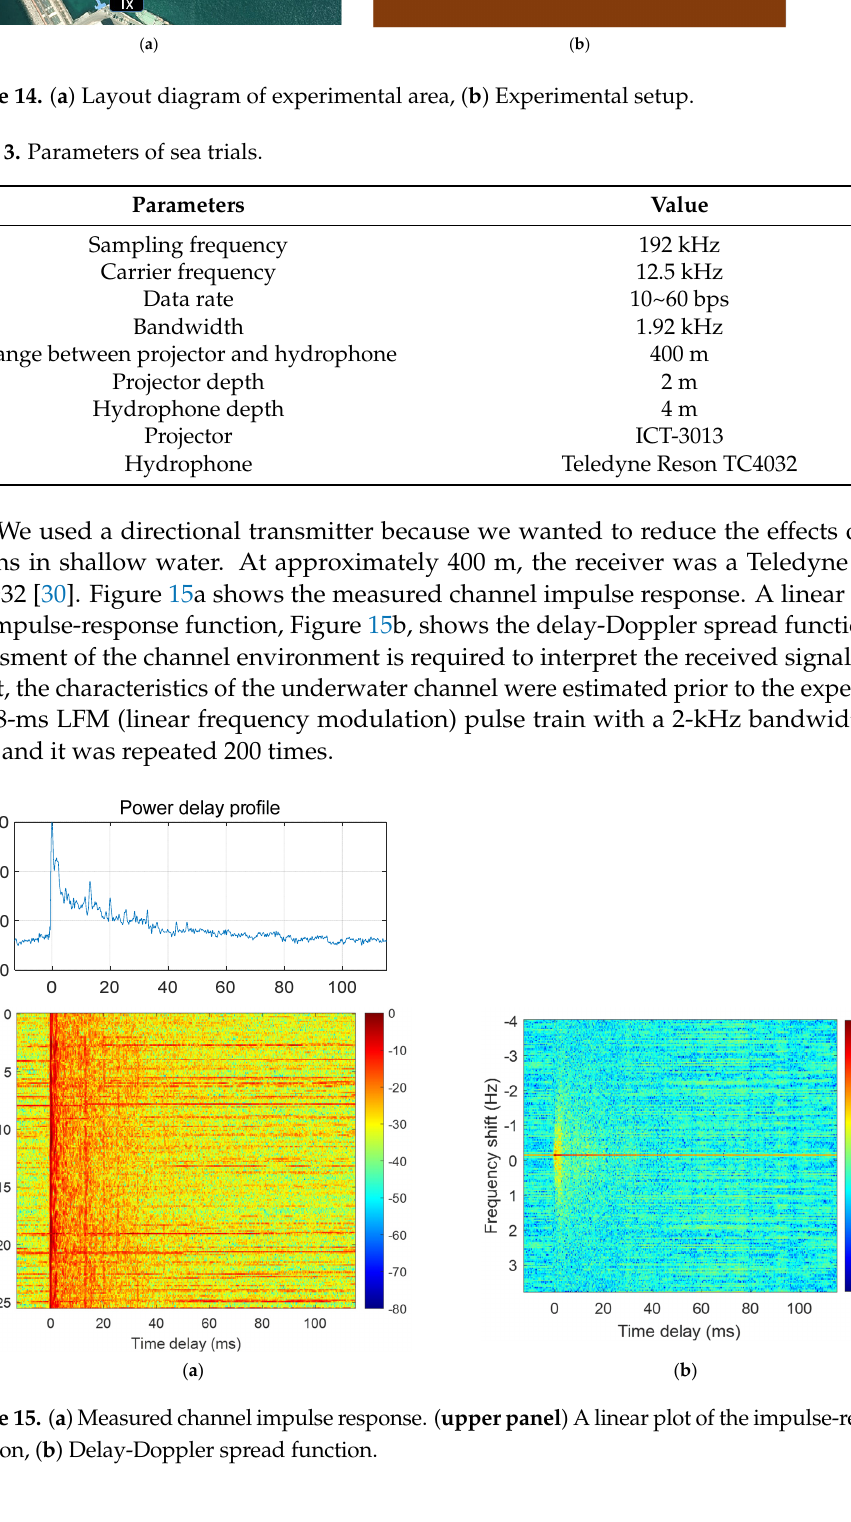
Figure 15. ( a ) Measured channel impulse response. ( upper panel ) A linear plot of the impulse-response function, ( b ) Delay ‐ Doppler spread function